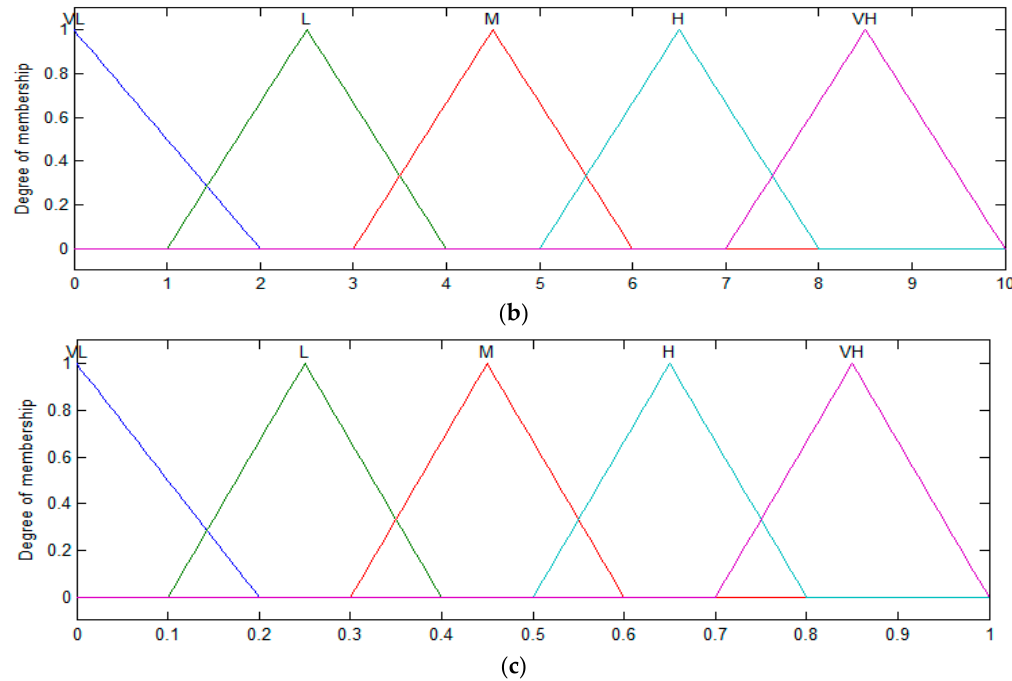
Figure 8. Input/output membership functions for ( a ) collaborative risk index 1; ( b ) collaborative risk index 2; and ( c ) integrated risk index.